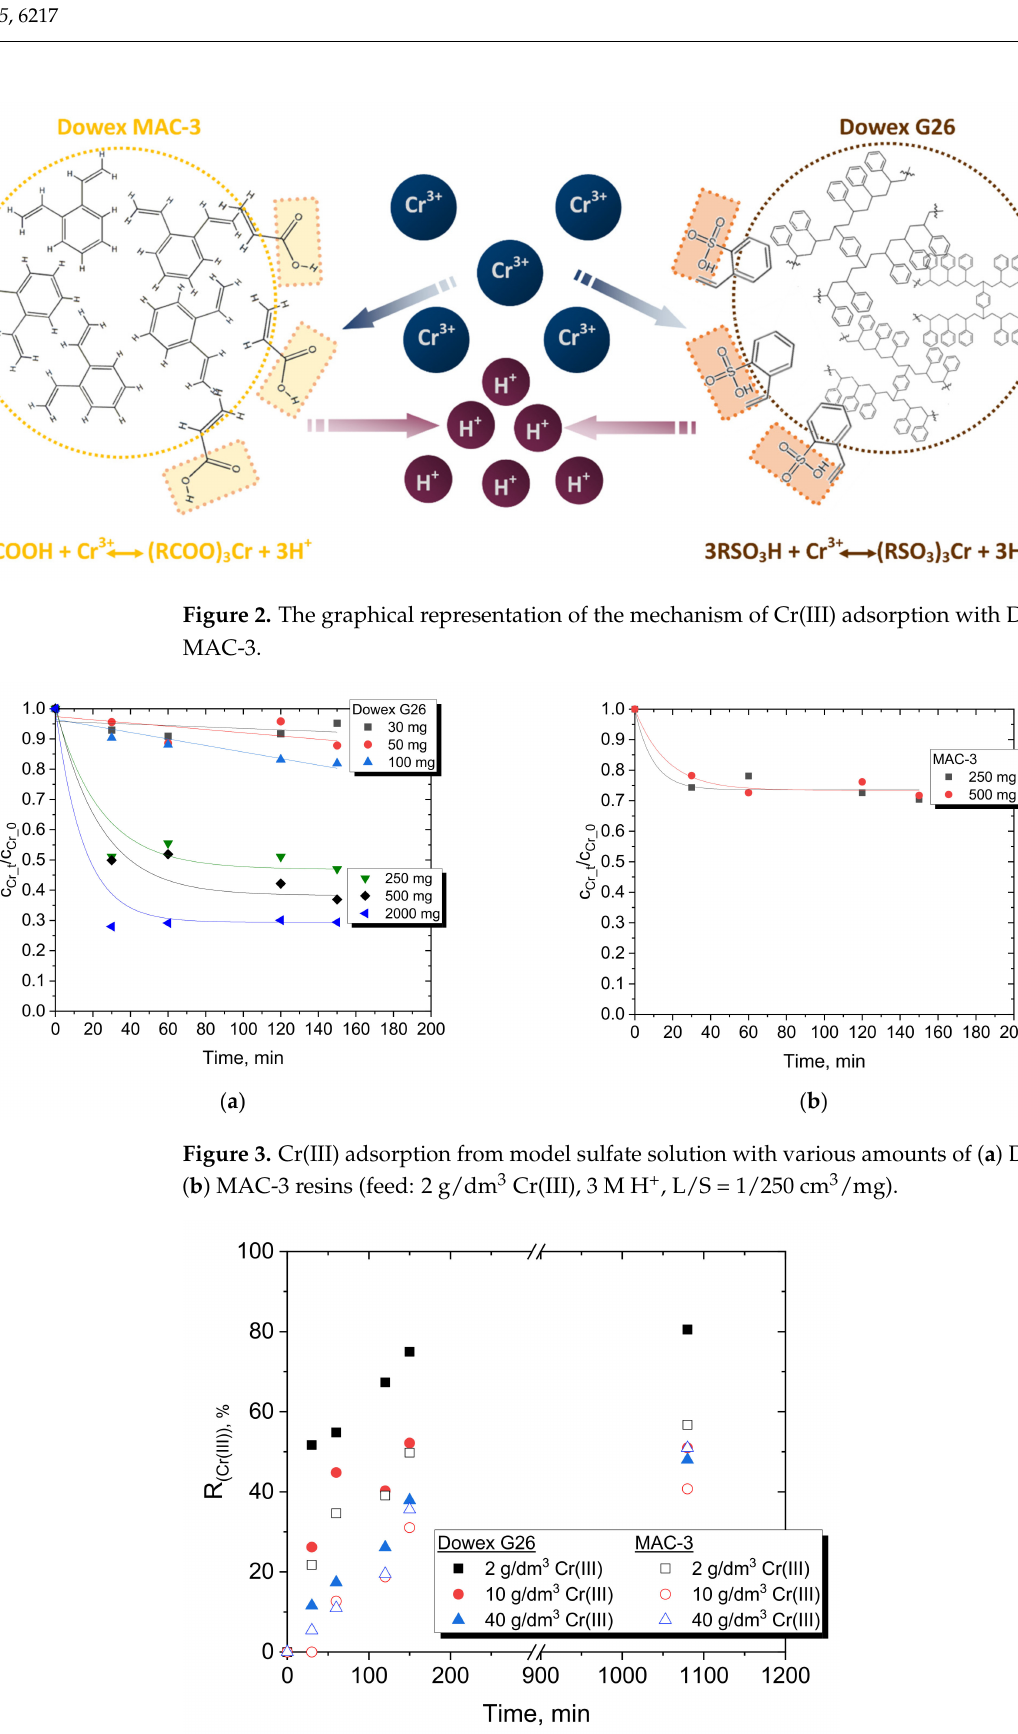
Figure 4. Comparison of Cr(III) removal over time with 500 mg of Dowex G26 ( , , ) or MAC- 3 ( , , ) from feeds of various Cr(III) concentrations (3 M H + , L/S = 1/250 cm 3 /mg). As expected, with increasing amounts of Dowex G26 resin (decreasing L/S ratio from 1/15 to 1/1000 cm 3 /mg), the concentration of Cr(III) in the feed is reduced even by two- thirds for 2000 mg of the resin used. However, there is no large difference in decreasing Cr(III) concentration in the feed between the use of 500 and 2000 mg of Dowex G26, and therefore, 500 mg was chosen for most adsorption experiments. Based on the preliminary results for Dowex G26 (Figure 3a), only two amounts of resin were investigated for MAC- 3, i.e., 250 and 500 mg (Figure 3b). It is visible in both Figure 3 and Figure 4 that Cr(III) adsorption is more efficient with Dowex G26 than with MAC-3. Especially when the initial concentration of Cr(III) is low, Dowex G26 (L/S = 1/250 cm 3 /mg) retains 80% of the metal ions, while MAC-3 adsorbs more than 50%. When 40 g/dm 3 Cr(III) was present in the feed, Dowex G26 and MAC-3 were able to remove comparable amounts from the aqueous solution, close to 50%. It should also be noted that 150 min is enough to achieve equilibrium (the Cr(III) concentration does not change) for adsorption with both resins in the amount range of 250 – 2000 mg. Because from a practical point of view, the influence of pH on adsorption efficiency is important, the effect of pH on the adsorption of Cr(III) by Dowex G26 and MAC-3 was studied using a model solution containing 2 g/dm 3 Cr(III) at pH −0 .5 (3 M H + ), 2.3, 4.4, and the results are shown in Figure 5. Typically, for cationic exchange resins, the capture of metals increases with increasing pH. It is worth mentioning that even at high H + , i.e., low pH, the adsorption efficiency of Cr(III) with Dowex G26 exceeds 60% after 2.5 h of contact. Following the observations of Alguacil for the acidic resin Amberlite 200 [24], it can be assumed that Dowex G26 also has the potential to be applied to remove Cr(III) even from solutions of high acidity. Unlike Dowex G26, weak acidic MAC-3 does not show good Cr(III) removal properties after 150 min of contact (maximum 45% Cr(III) removal). After 1080 min of phase contact, the adsorption efficiency with MAC-3 increases to even 65% at pH 4.4 and L/S = 1/250 cm 3 /mg (500 mg of resin). This again confirms that this resin is not suitable for the tested system.